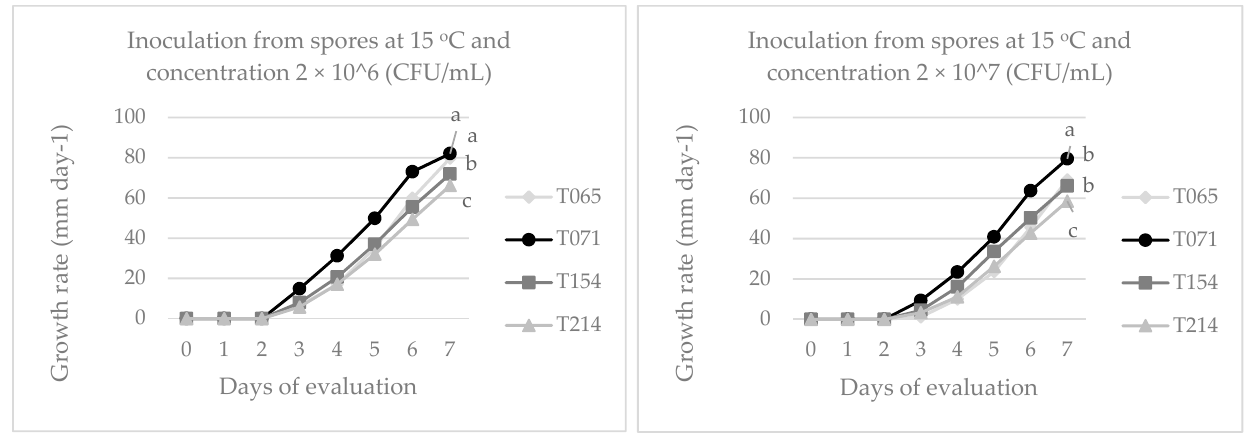
Figure 4. Growth rate of the different Trichoderma strains analyzed in this work from two spore concentrations at 15 °C. Values followed by the same letter do not differ significantly ( p = 0.05).